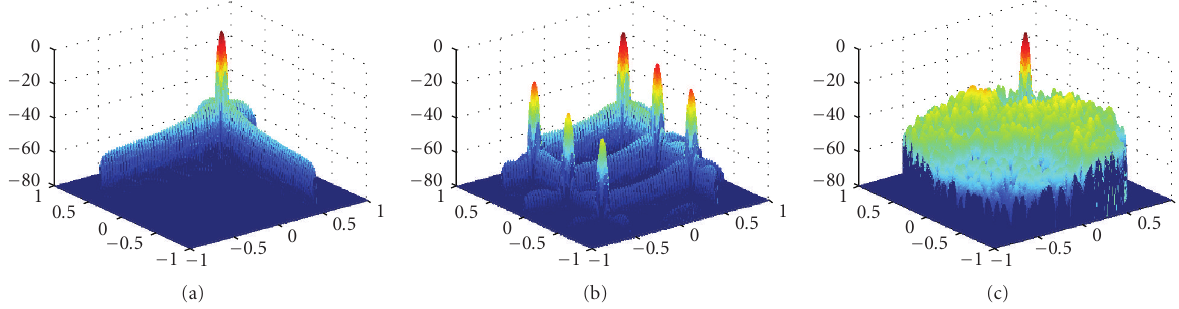
Figure 3: Radiation patterns at f/ f 0 = 1.3 for an array with time delay at element level (a), at rectangular subarray inputs (b) and at L-octomino subarray inputs